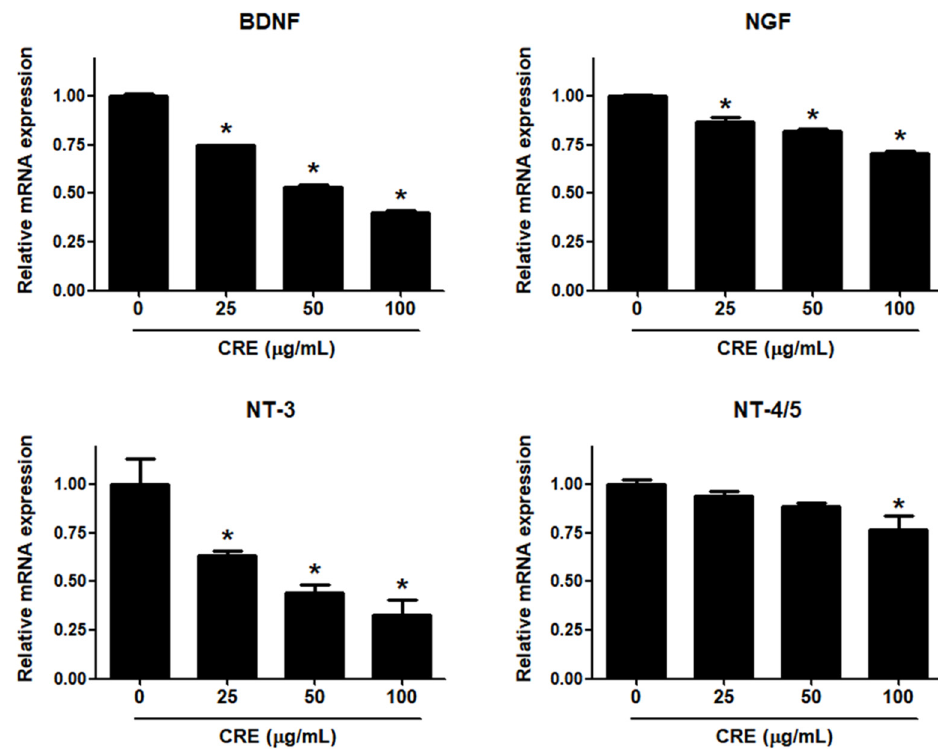
Figure 2. Effect of CRE on the expression of neurotrophins in endometriotic cells. The 12Z cells were treated with CRE (25, 50 and 100 µg/mL) for 24 h, and then the mRNA expression of neurotrophins (BDNF, NGF, NT-3 and NT-4/5) was measured by real-time RT-PCR. All expression levels were normalized to GAPDH. Results are the combined data (mean ± S.D.) from three independent experiments. * p < 0.05 compared with control group.